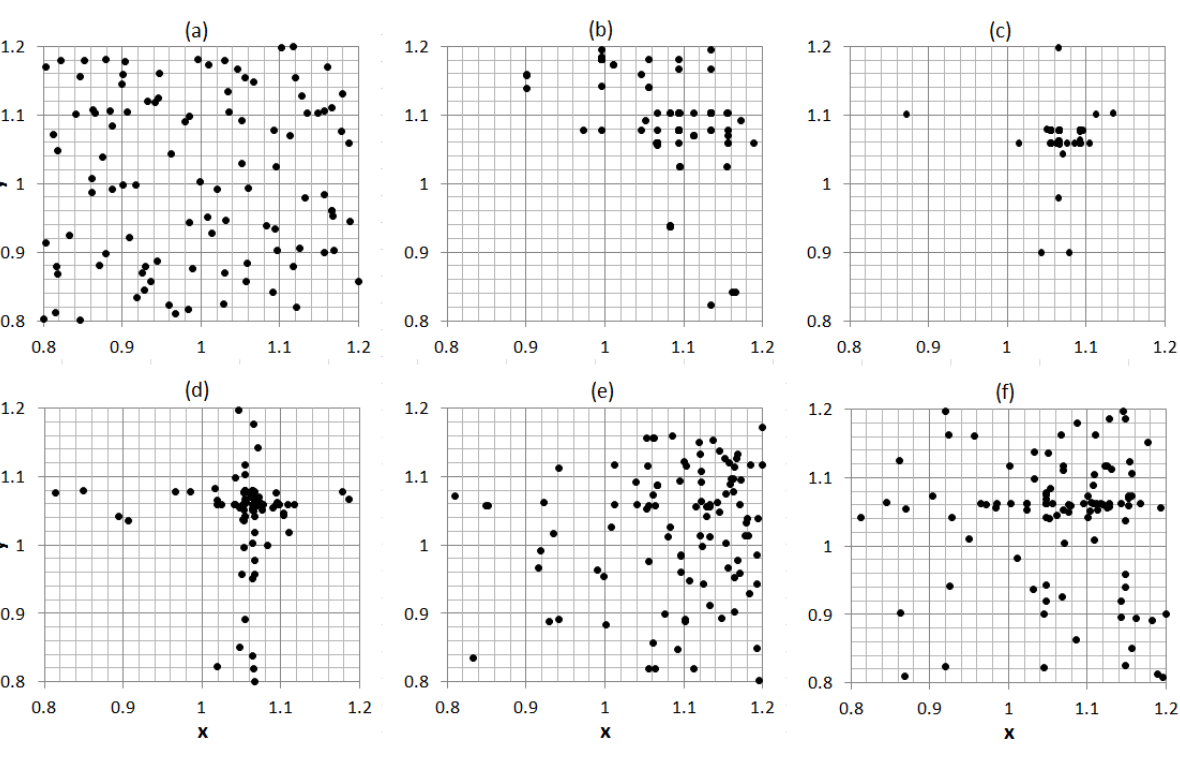
Figure 8. Evolution of the population during the GA evolutionary run and development of the crosshair pattern on part (D). The x and y are individuals for optimized parameters of industrial land use (31% of total area) and high residential area (28% of total area) in WD#10, respectively. ( a ) Initial population; ( b ) 5th generation; ( c ) 10th generation; ( d ) 15th generation; ( e ) 100th generation; ( f ) 200th